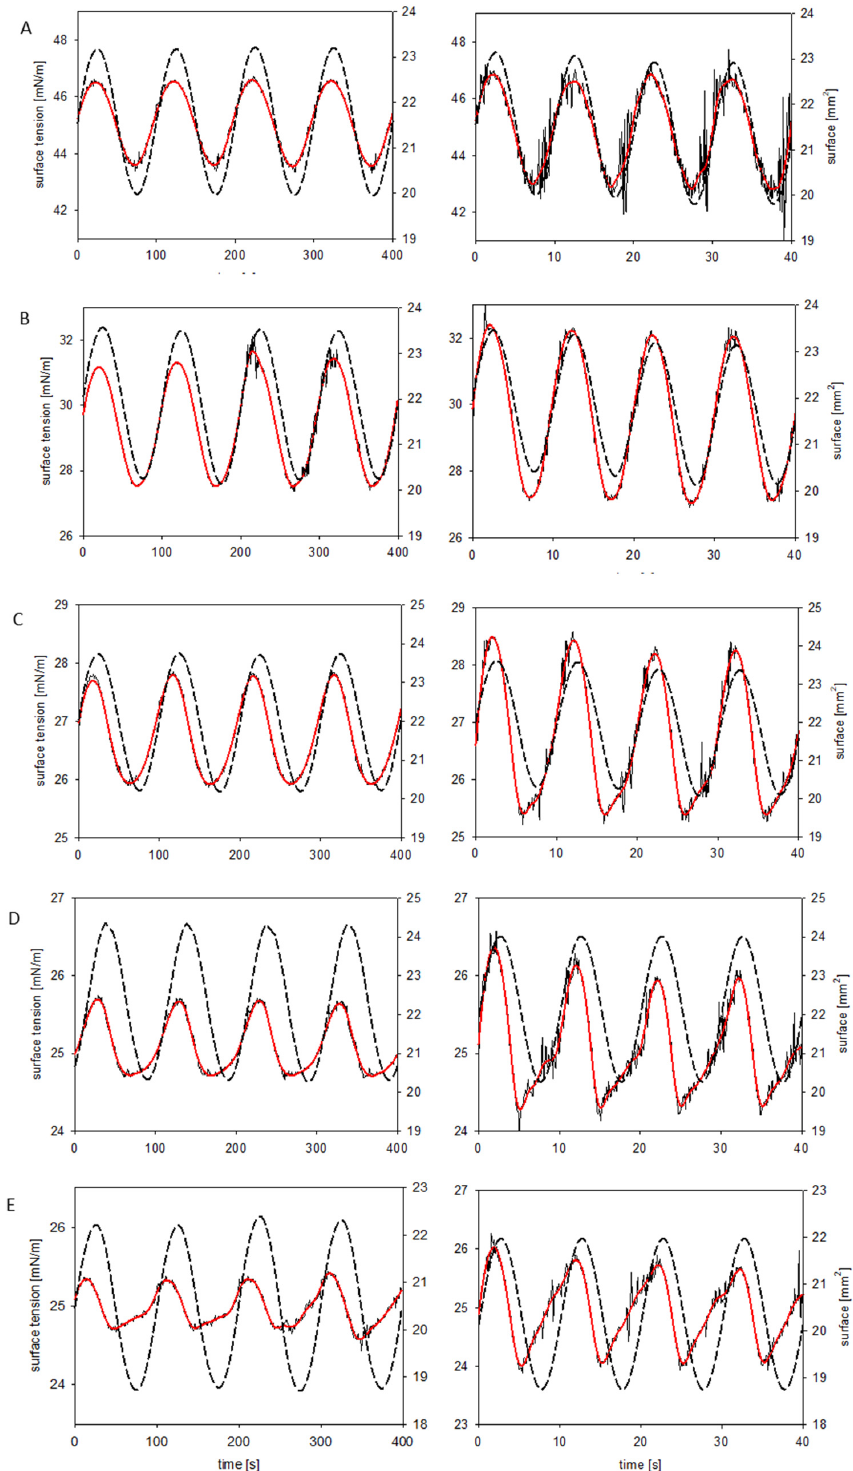
Figure 5. Oscillations of the drop area (dashed line) and the corresponding changes of the surface tension. Red line: the surface tension after Loess smoothing. LAE concentration: ( A ) 0.2 mM; ( B )